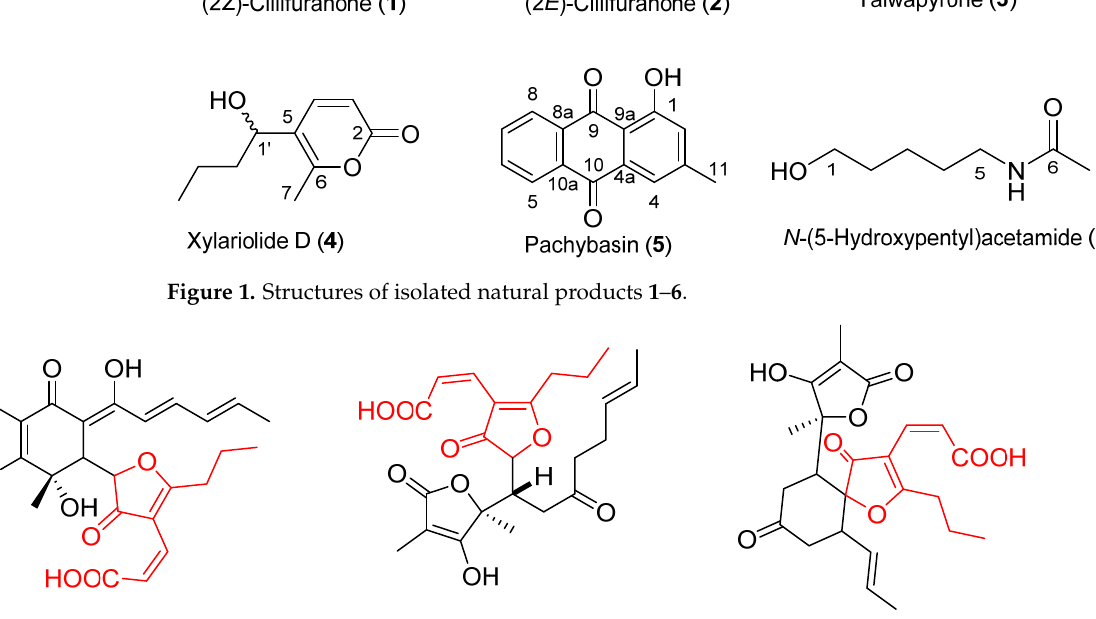
Figure 1. Structures of isolated natural products 1 – 6 .